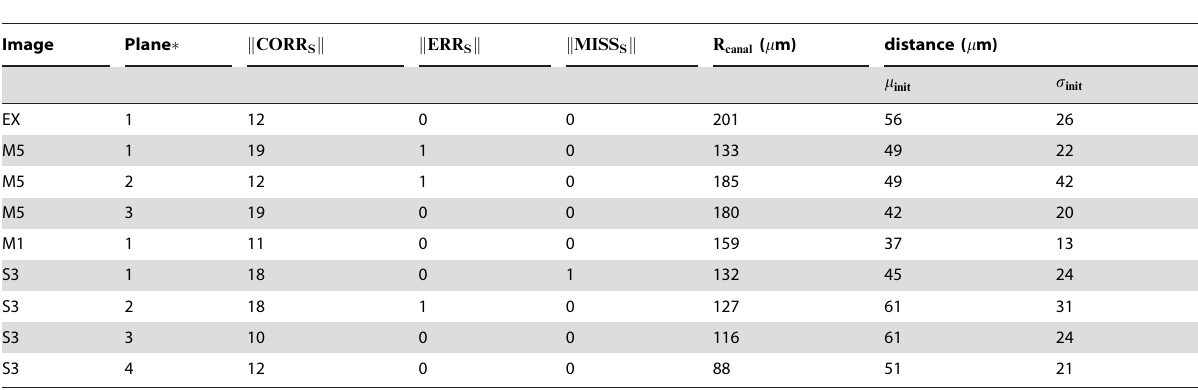
Table 4. Results of the automatic seed-point detection.